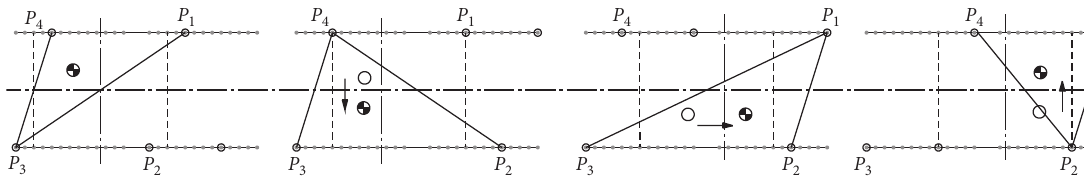
Figure 5: Sketch of barycenter adjustment.